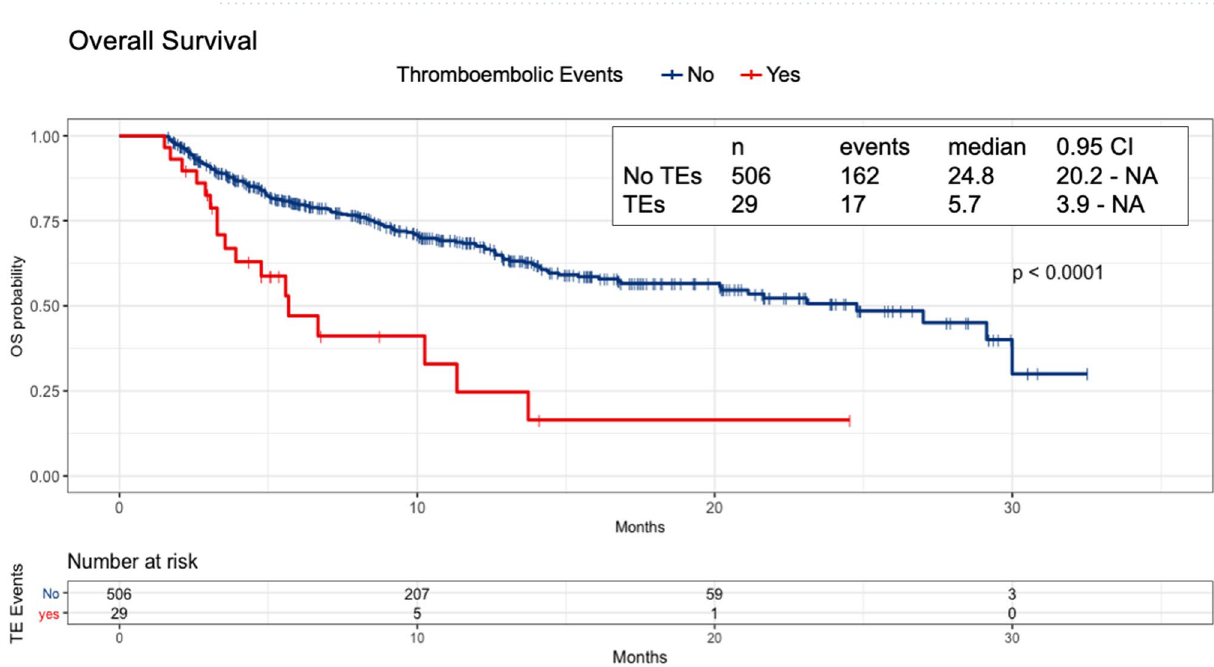
Figure 3. Kaplan Meier curves of Overall Survival according to the occurrence of thromboembolic events during or after hospitalization. NA not available (not reached), OS Overall survival, TEs thromboembolic